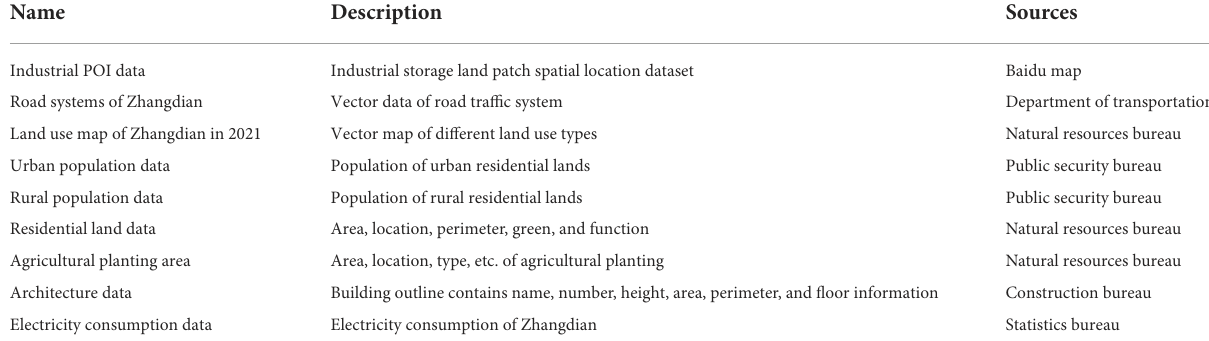
TABLE 1 Data sources and